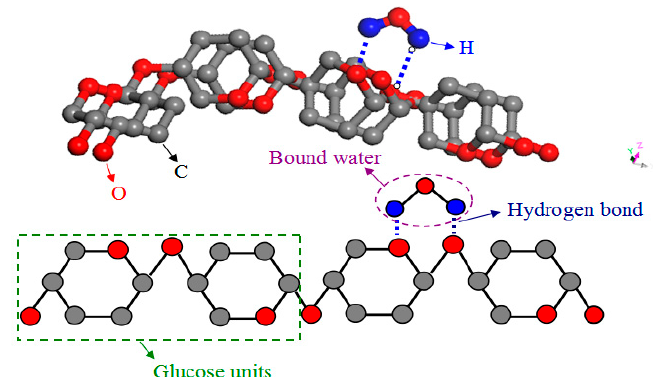
Figure 12. Hydrogen bond formation between bound water and the amorphous region of the cell.